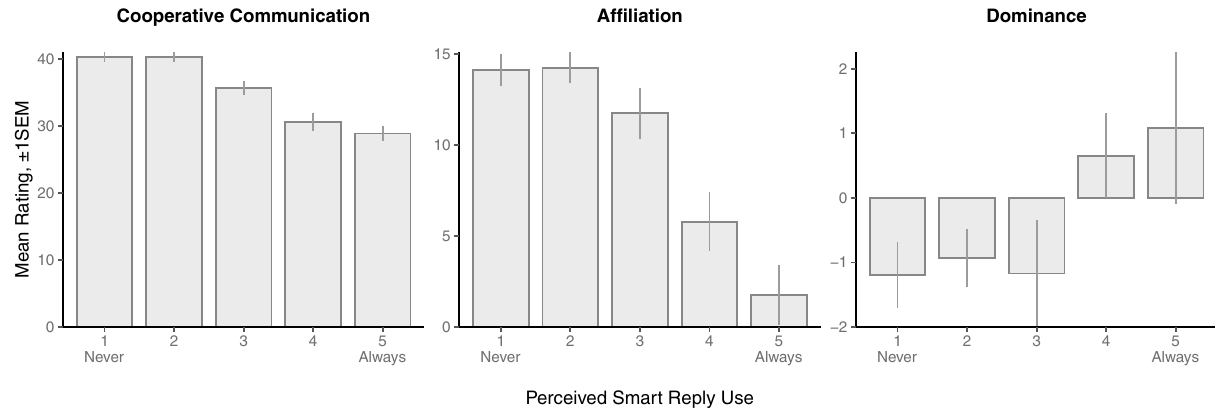
Figure 2. Average rating of the partner’s cooperative communication, affiliation, and dominance by the self for different levels of perceived smart reply (SR) use by the partner ( N = 361). Error bars show one cluster- robust standard error above and below the mean. See Supplementary Table S6 for details about the frequency of responses per response